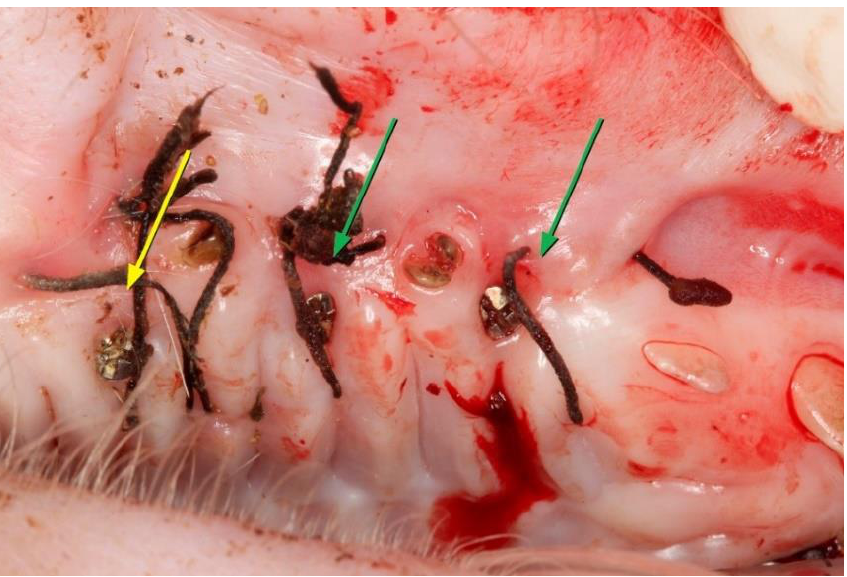
Figure 3. Graft condition 15 days after surgical placement. The yellow arrows indicate the location of autologous connective tissue graft (ACTG), and the green arrows indicate dermal matrix